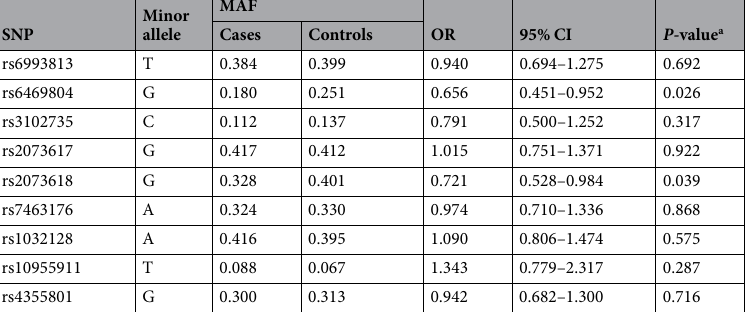
Table 3. Association of 9 SNPs with osteoporotic fracture. a P -value of significance was set at 0.006 by using the Bonferroni Correction.